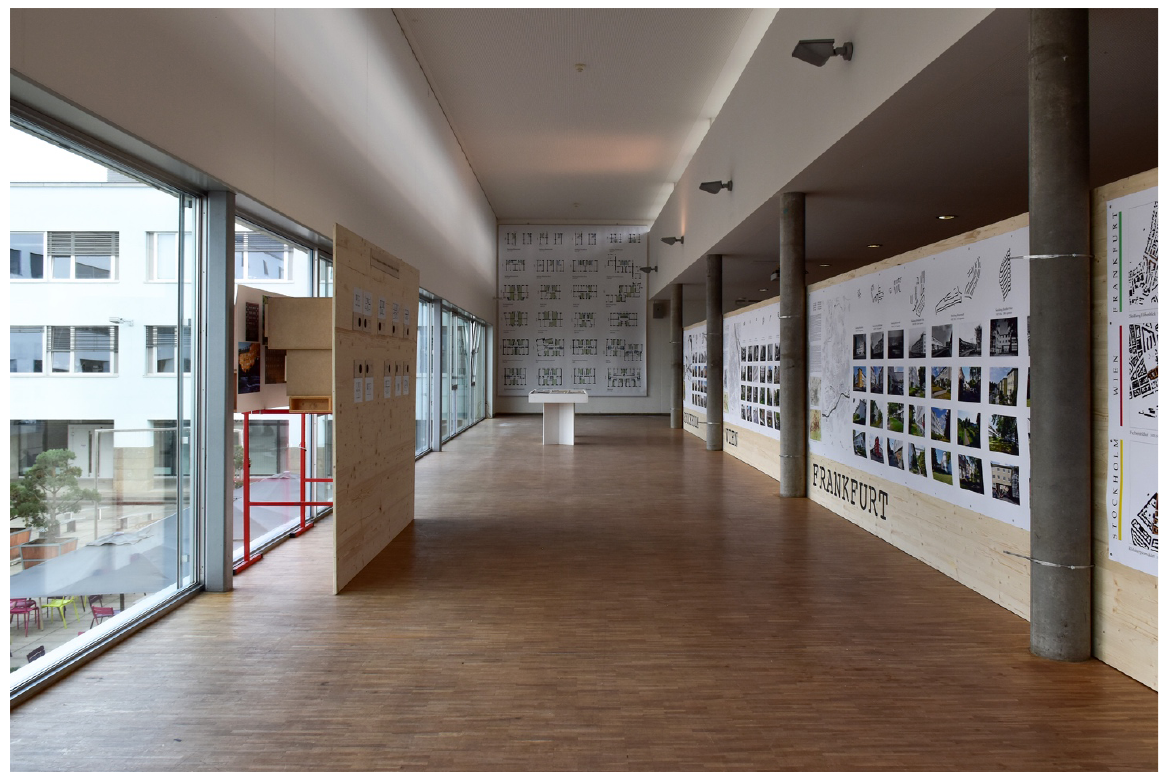
Figure 2. Main exhibition space with four thematic sections: on the right side, comparison with urban densities and ur- ban policies of Frankfurt, Vienna and Stockholm; on the background, dwelling units and; on the left side, one-room scale models. Source: Authors.